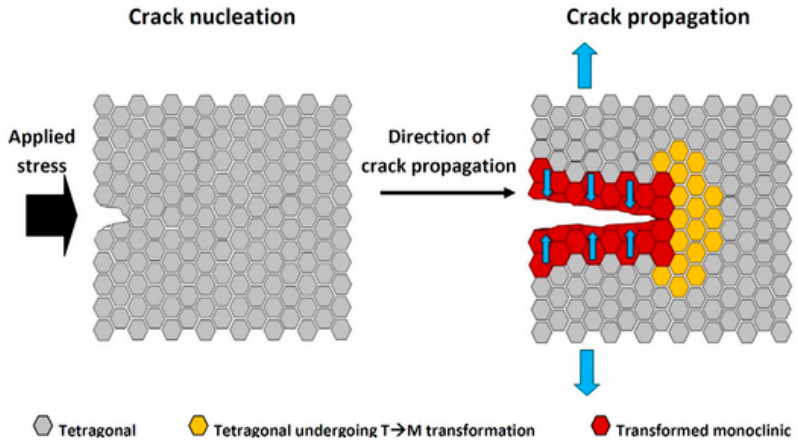
Figure 12. Schematic diagram of ZrO 2 phase transformation toughening mechanism [82]. Reprinted with permission from [82]; 2019 Elsevier.